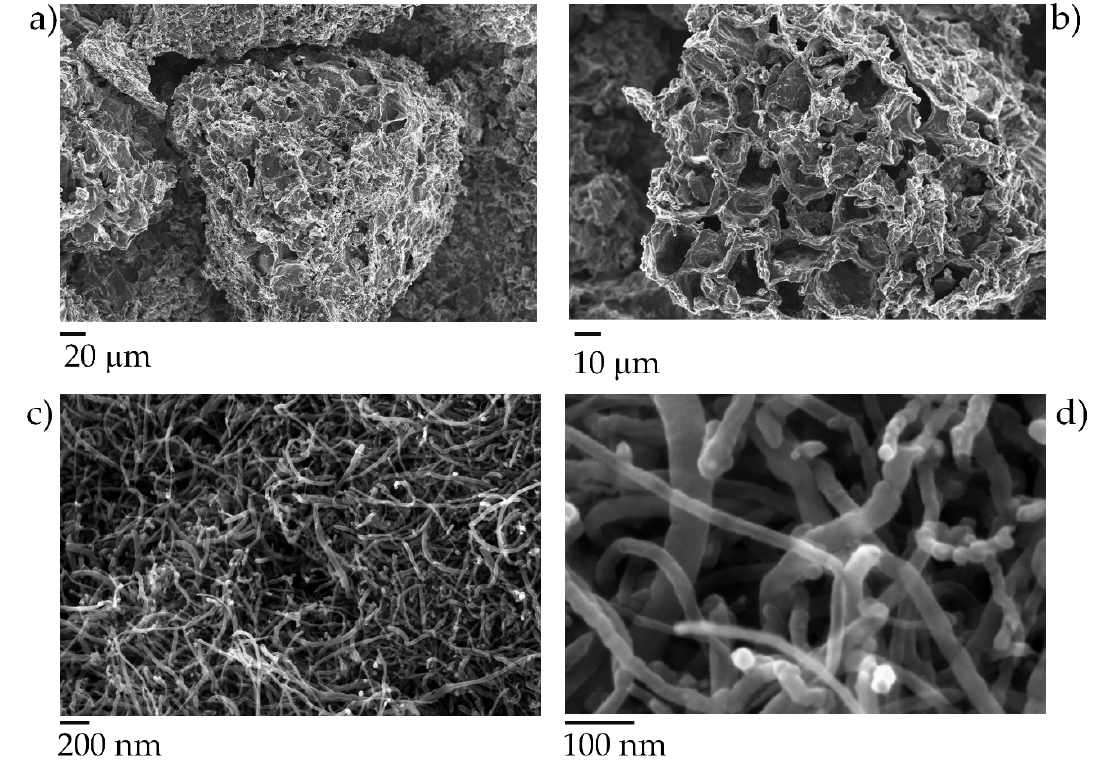
Figure 4. FESEM captures of BC ( a – b ) and multiwalled carbon nanotubes (MWCNTs; c – d ) at different magnifications. It is worthy to note the highly porous structure of Biochar